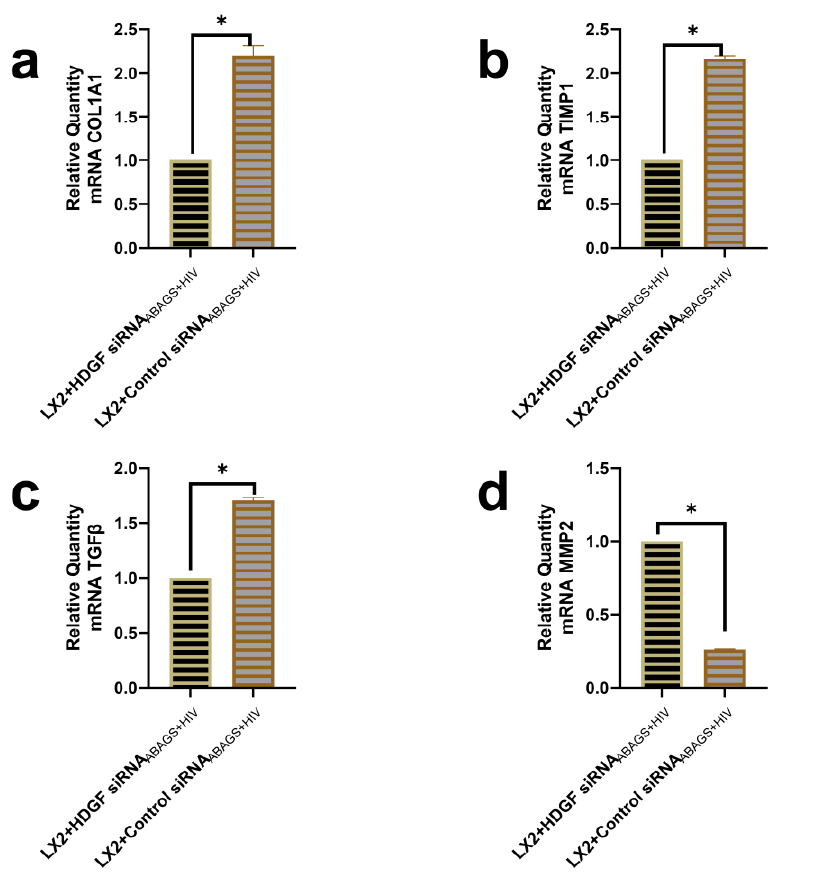
Figure 6. Silencing HDGF in RLW ABs attenuated profibrotic genes in LX2 cells. RT-PCR analysis of ( a ) COL1A1 mRNA, ( b ) TIMP1 mRNA, and ( c ) TGF β mRNA. ( d ) MMP2 mRNA. Data are from 3 independent duplicate experiments presented as mean ± SEM. Bars with * are significantly different from each other ( p ≤ 0. 05).